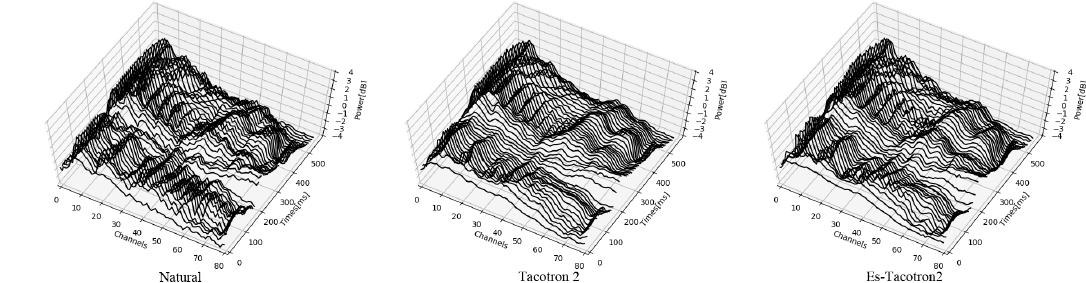
Figure 4. An example of spectral segment for synthesized spectrogram from the natural mel spectrogram ( left ); original Tacotron 2 synthesized mel spectrogram ( middle ); and Es-Tacotron2 synthesized mel spectrogram ( right ) with teacher-forcing